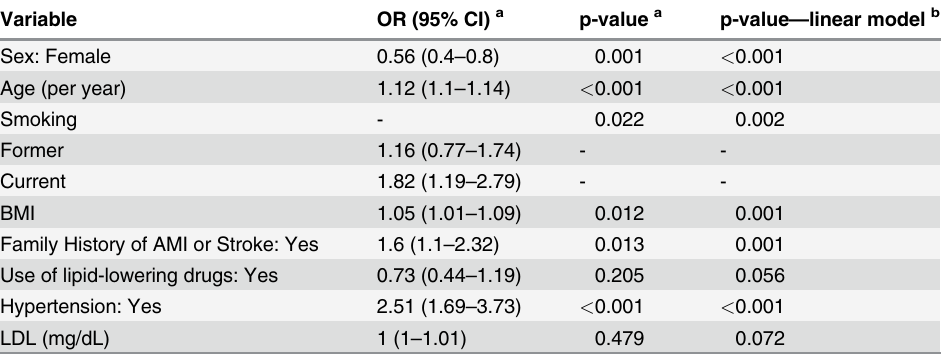
Table 2. Predictors of cIMT determined from multivariable models selected after the adaptive lasso